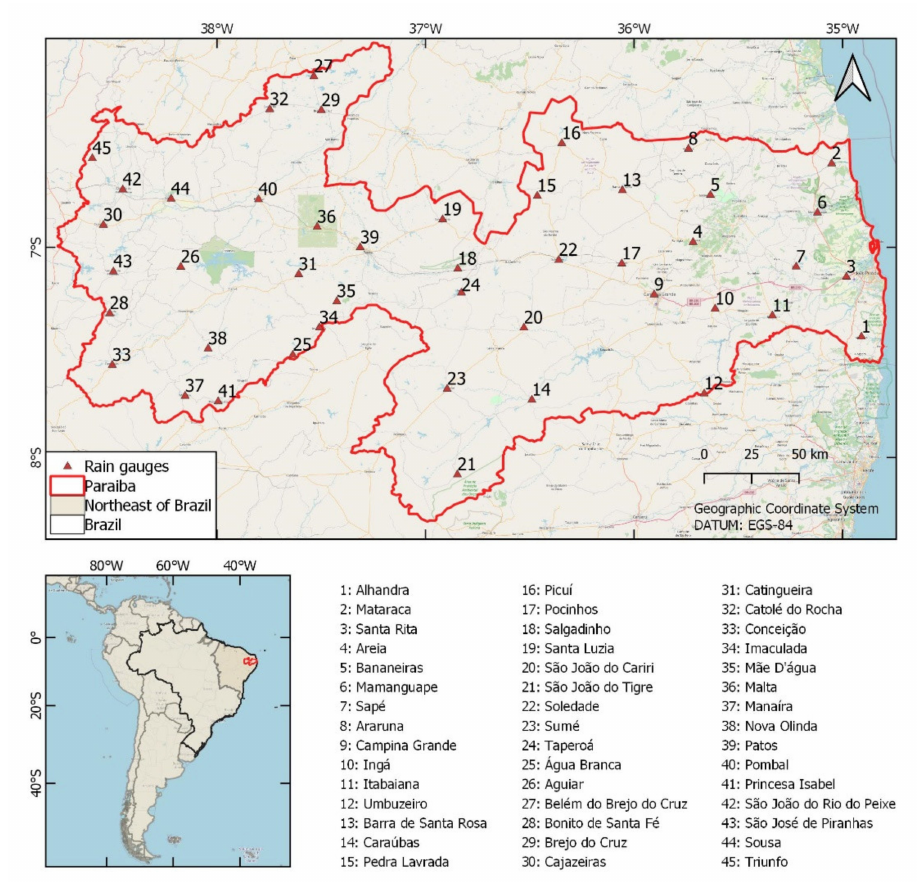
Figure 1. Location of the used rain gauges in the state of Para í